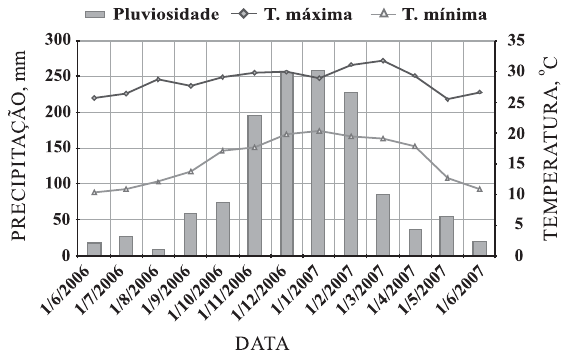
Figura 1. Dados pluviométricos e de temperaturas máxima e mínima (média mensal) ocorridos durante a condução dos experimentos - anos agrícolas 2006 e